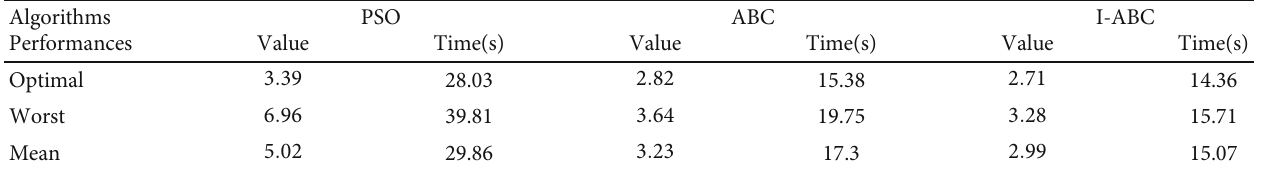
Table 3: Results comparison for three